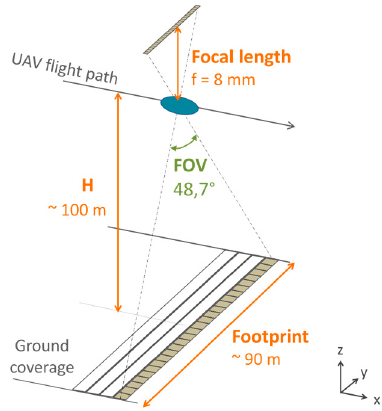
Figure 3. Geometry of the acquisition at 100 m of altitude. FOV: Field Of View.